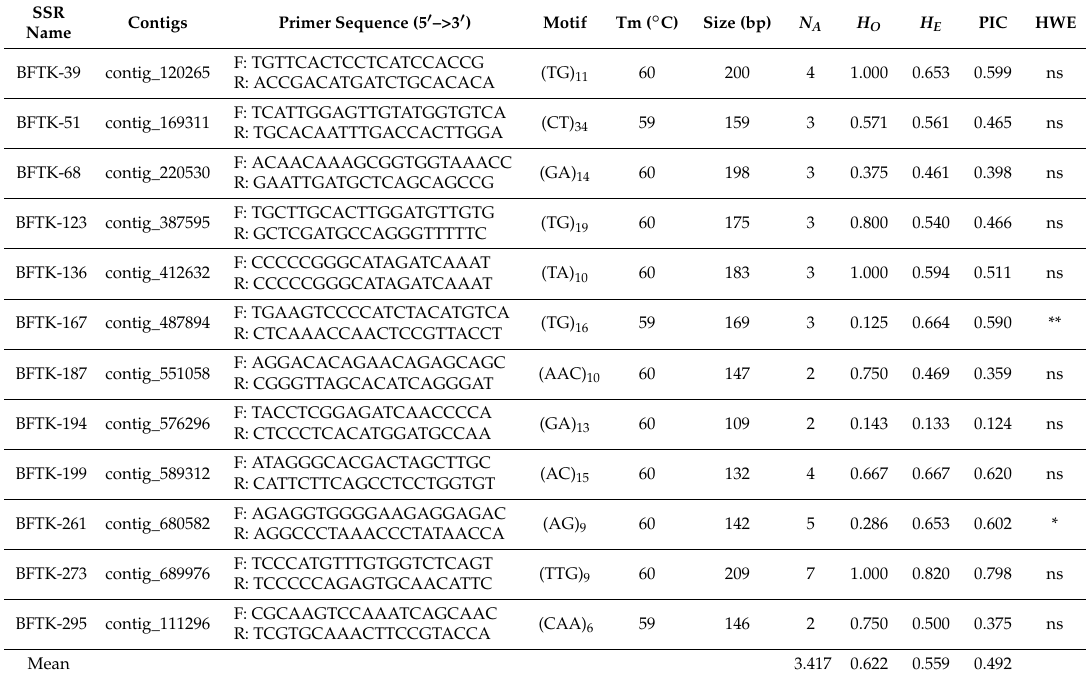
Table 4. Characterization of 12 polymorphic